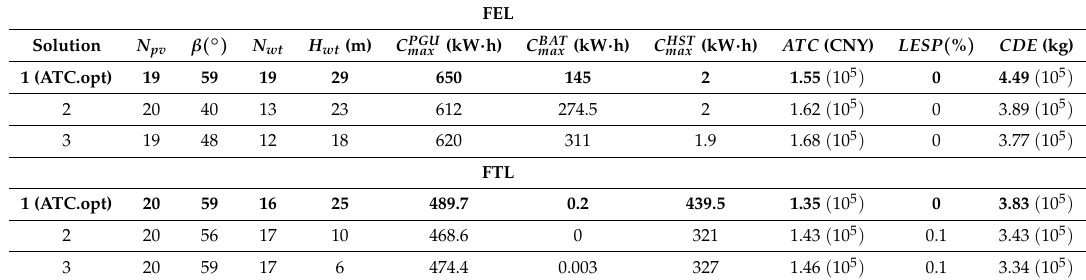
Figure 11. RECCHP in FTL. Table 5. Selected results using PICEA-g with specified